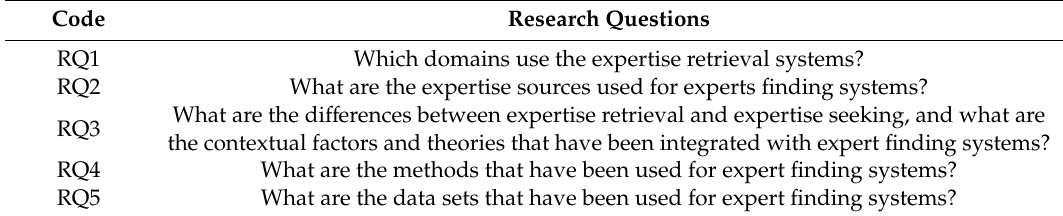
Table 1. Research